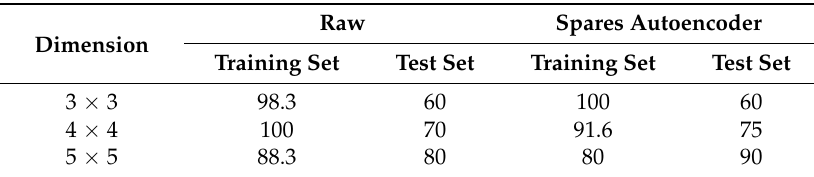
Table 5. Accuracy of three kinds of feature matrix with radial basis function (RBF) (%). Raw Spares Autoencoder Dimension Dimension